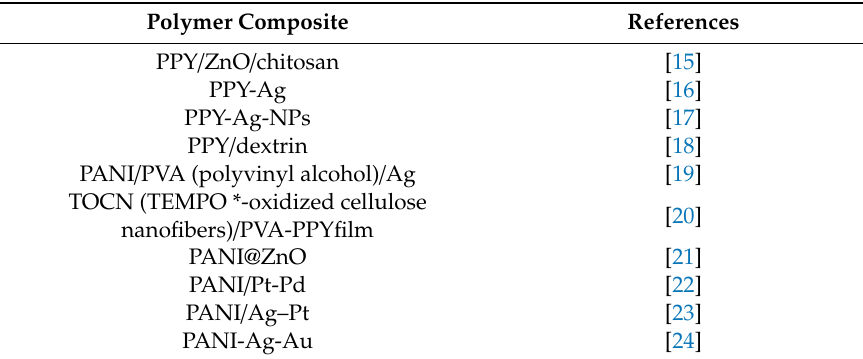
Table 1. The literature on di ff erent polymer composites. Polymer